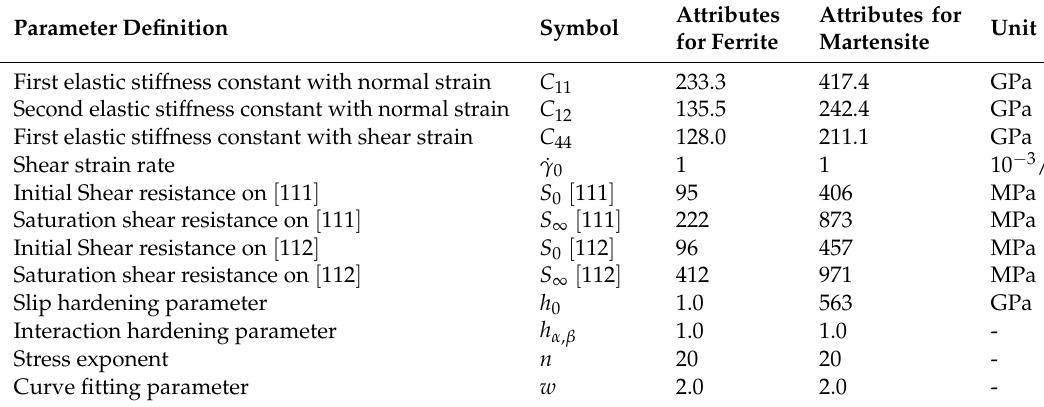
Table 2. Parameters for ferrite and martensite adopted from literature [45] for the numerical simulation